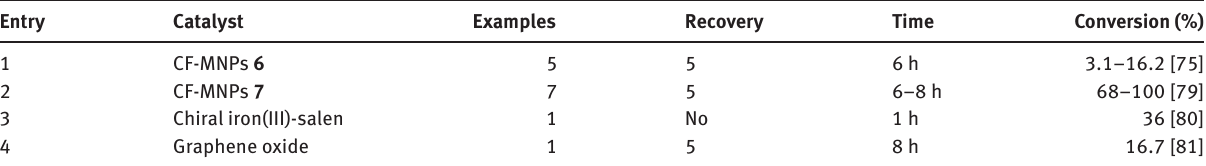
Table 5: Comparison of the activity of CF-MNPs catalysts with other reported catalysts in oxidation of hydrocarbons. Entry Catalyst